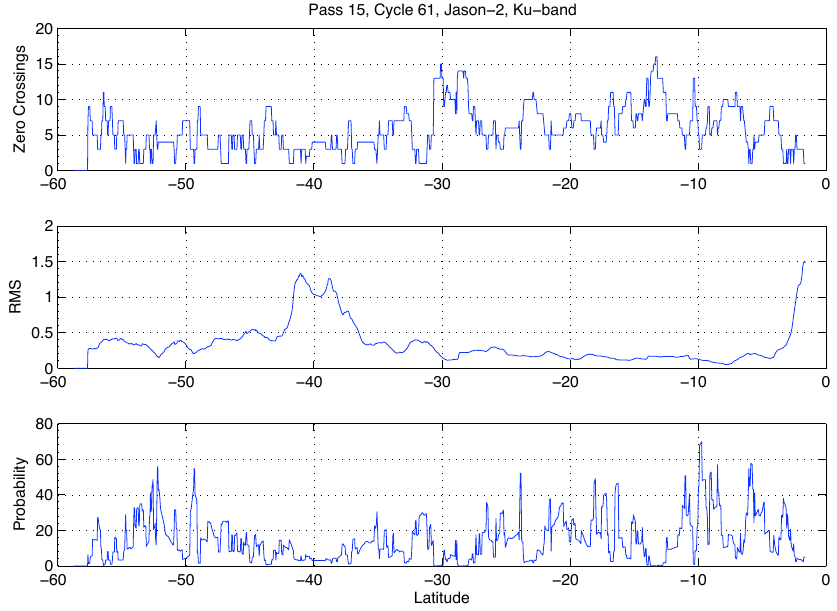
Fig. 12. Statistical randomization tests using a “sliding window” for pass 15 of Jason-2 cycle 61. A randomization test is conducted for every 3.2 ◦ window and the statistical significance is computed to test the hypothesis that the surface roughness variations with and without the tsunami present are not significantly different. The x-axis values represent the center point of each window.